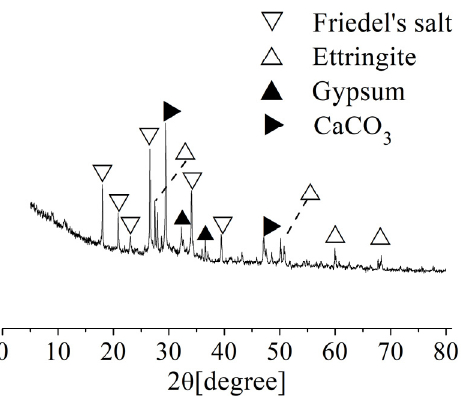
Figure 6. XRD analysis of the corrosion products of the concrete after corrosion for 10 months.